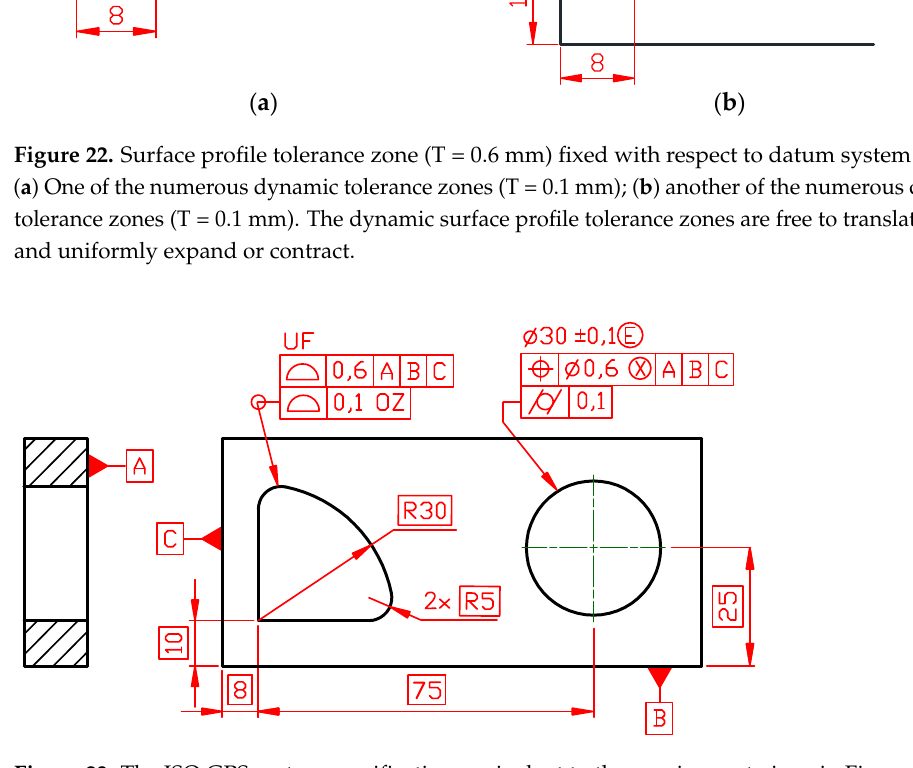
Figure 22. S urface profile tolerance zone (T = 0.6 mm) fixed with respect to datum system A|B|C. ( a ) One of the numerous dynamic tolerance zones (T = 0.1 mm); ( b ) another of the numerous dy- namic tolerance zones (T = 0.1 mm). The dynamic surface profile tolerance zones are free to translate, rotate and uniformly expand or contract.